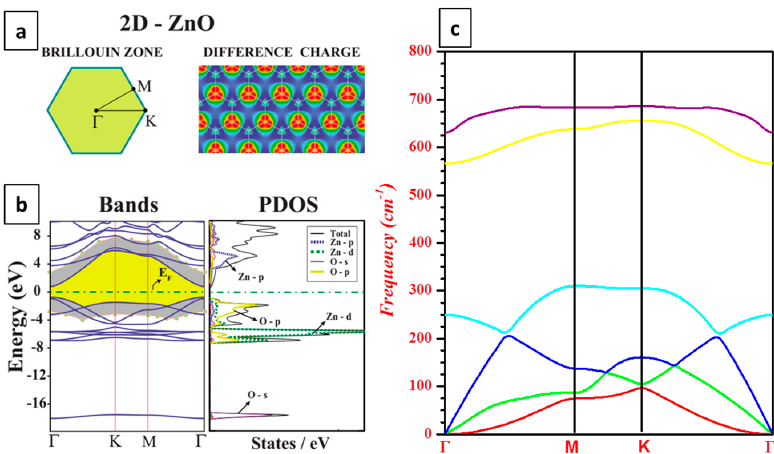
Figure 2. Graphene-like ZnO: electronic structure and properties. ( a ) Brillouin zone corresponding to planar hexagonal lattice and the difference charge density, ∆ ρ , in g-ZnO lattice. Reprinted with permission from Reference [6]. Copyright © (2009) American Physical Society. ( b ) Electronic band structure and density of states projected to the selected orbitals (PDOS) of constituent atoms of g-ZnO mono-layer. The band-gap is shaded (colored in yellow) and the Fermi level is set to zero. Band edges corrected by GW 0 are denoted by small (greenish) circles. The band-gap enlarged after GW 0 correction is shaded (colored in grey). Reprinted with permission from Reference [6]. Copyright © (2009) American Physical Society. ( c ) The phonon dispersion curves in the Brillouin zone of g-ZnO. (Figure 2 c kindly provided by Z.C. Tu).